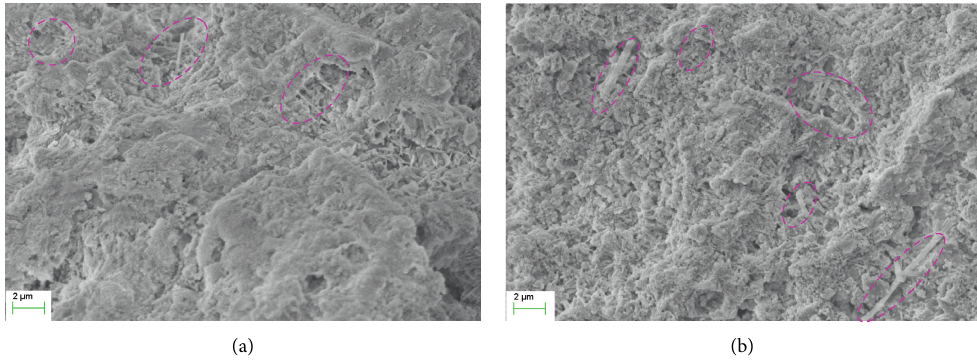
Figure 19: The SEM images of foamed concrete structures. (a) Glass fiber. (b) Polypropylene